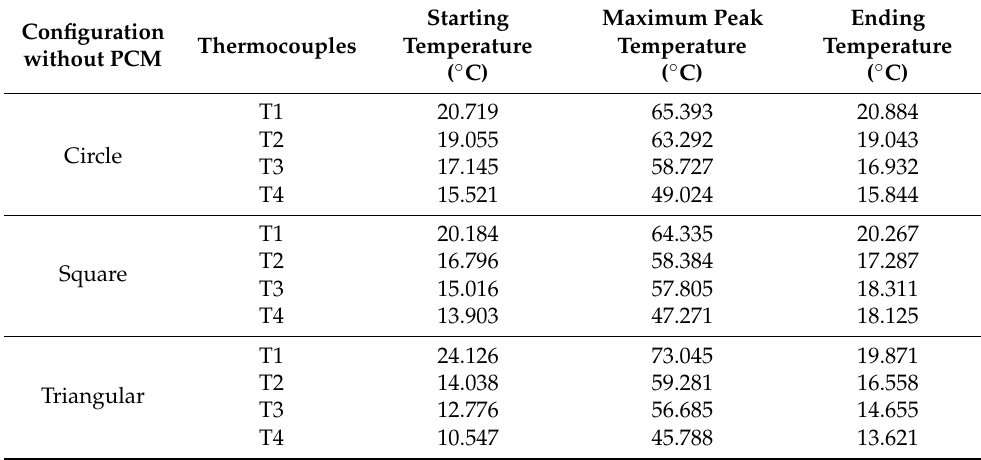
Table 4. Temperature data for configuration with PCM. Configuration